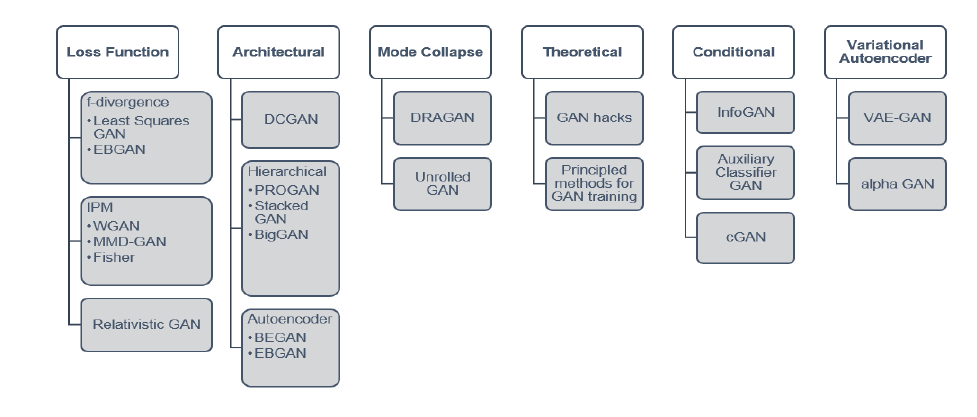
Figure 3. Taxonomy of GAN